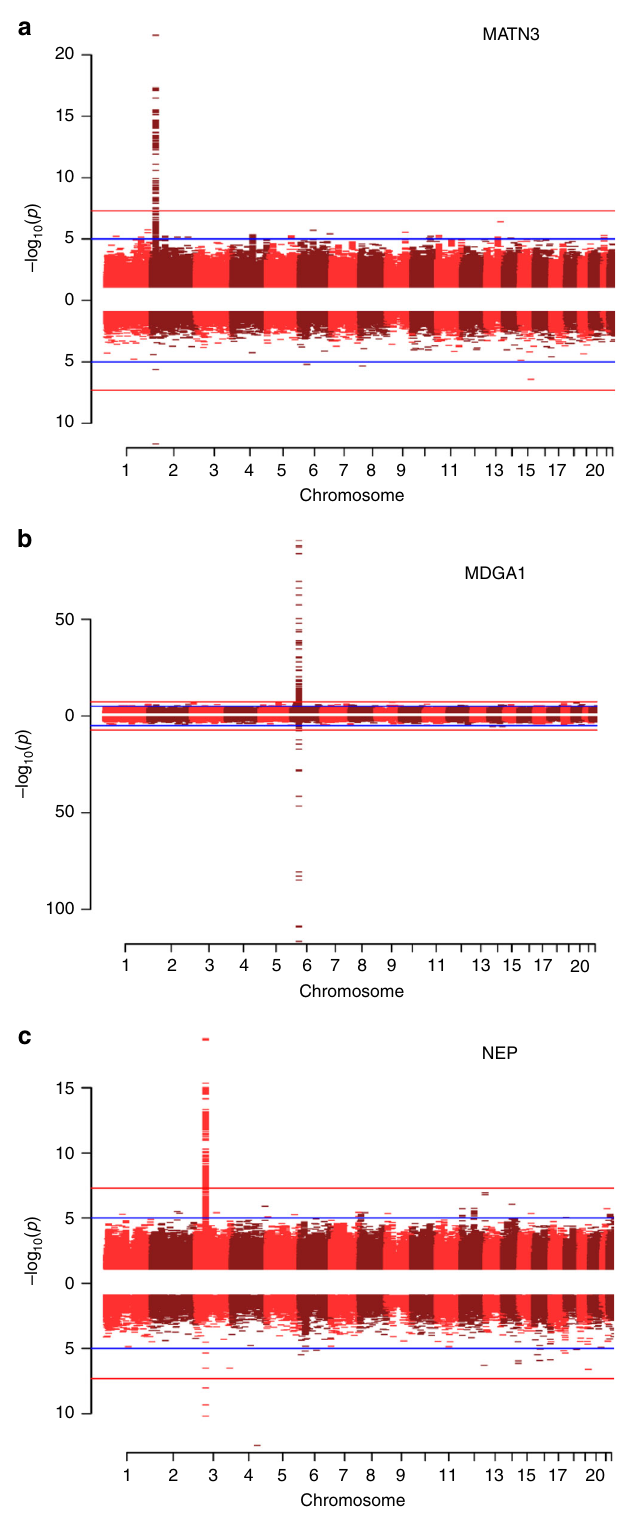
Fig. 4 Miami plots of three neurological proteins with both genome-wide signi fi cant SNP and genome-wide signi fi cant CpG associations. The top half of the plot (skyline) shows the results from the GWAS on protein levels, whereas the bottom half (waterfront) shows the results from the EWAS. Blue lines indicate suggestive associations; red lines indicate epigenome-wide signi fi cant associations. a Miami plot for MATN3 (chromosome 2: 20,191,813 – 20,212,45 5). b Miami plot for MDGA1 (chromosome 6: 37,600,284 – 37,667,082). c Miami plot for NEP (chromosome 3: 154,741,913 –